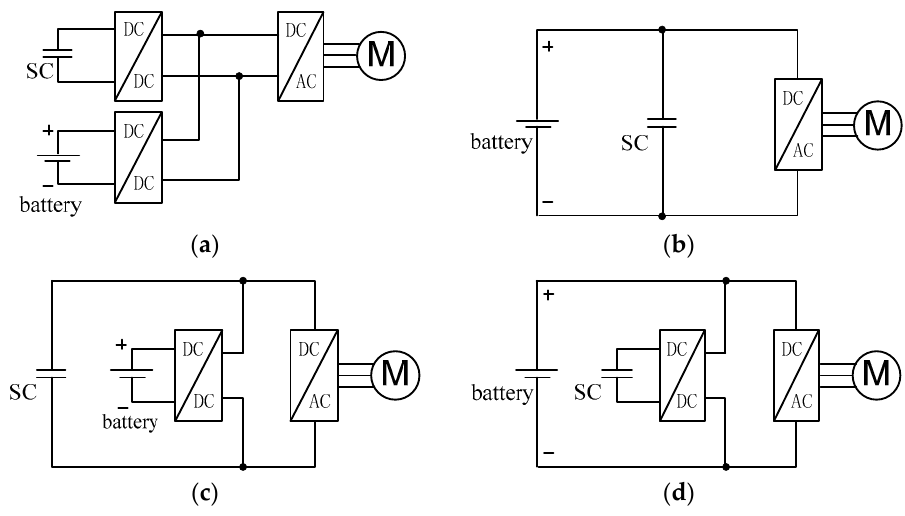
Figure 1. The topology of the electric vehicle HESS: ( a ) fully active topology; ( b ) passive parallel topology; ( c ) semi-active topology 1; and ( d ) semi-active topology 2.